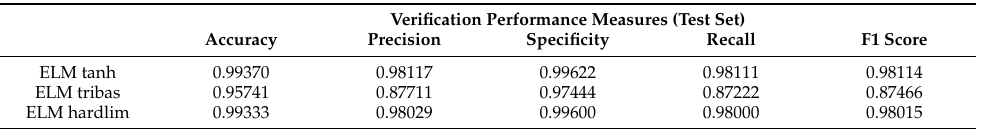
Table 10. Verification (test) classification performance measures of the ELM classifier for three different transfer functions of the ELM algorithm in dataset #1.